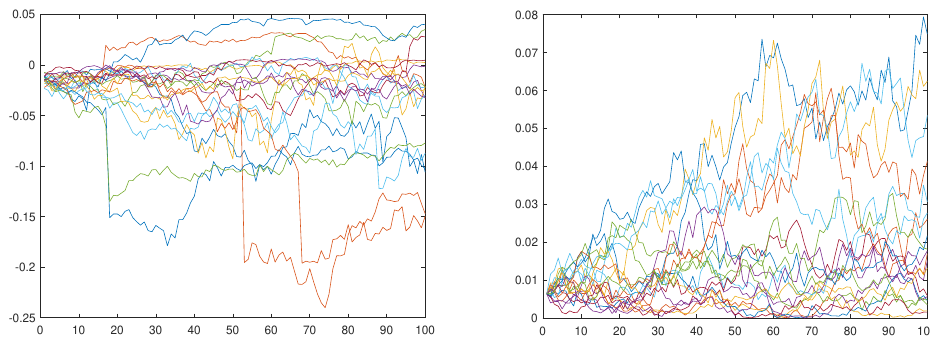
Figure 1. CGMYSV sample paths ( left ) and CIR sample paths ( right ).